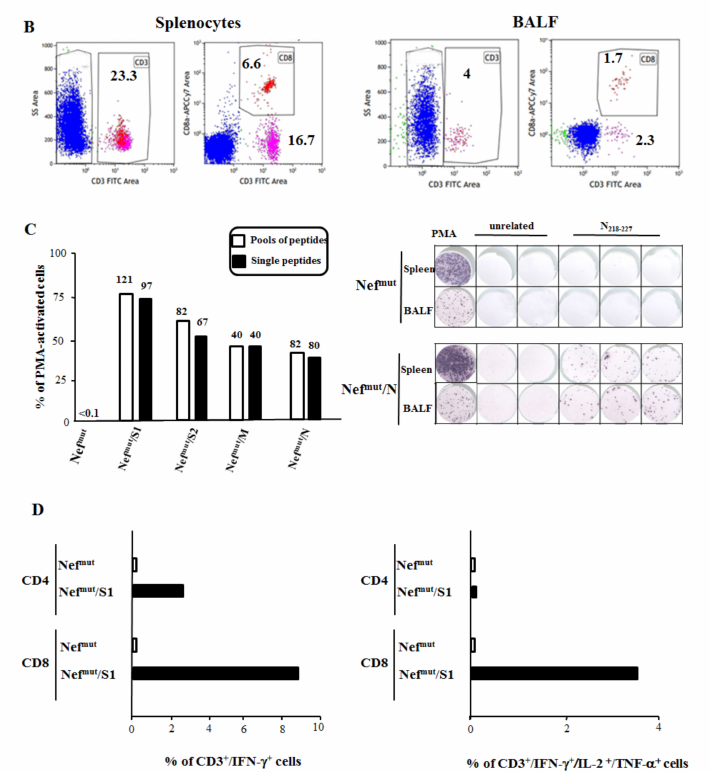
Figure 5. SARS-CoV-2 -specific total cell and CD8 + T cell immunity in both spleens and bronchoalveaolar lavage fluids (BALFs) of mice immunized i.m. by Nef mut -derived DNA vectors. ( A ) Total cell and CD8 + T cell immune responses in C57 Bl/6 and, for immunization with Nef mut /S2 expressing vector only, Balb/c mice inoculated i.m. with DNA vectors expressing Nef mut either alone (three mice), or fused with the indicated SARS-CoV-2 antigens (five mice per group). Total cell immune responses were measured using pools of 13- to 17-mers, whereas single octo-decamers were used to evaluate the CD8 + T cell immune responses. At the time of sacrifice, 2.5 × 10 5 splenocytes were incubated ON with either unrelated or SARS-CoV-2-specific peptides in triplicate IFN- γ EliSpot microwells. Shown are the numbers of SFUs/well as mean values of triplicates after subtraction of mean spot numbers measured in wells of splenocytes treated with unspecific peptides. Reported are intragroup mean values + standard deviations also. No virus-specific immune responses were detected using a pool of peptides from a heterologous viral product, i.e., HCV-NS3 (not shown). Circles sign values measured in cultures of splenocytes isolated from each injected mouse. The results are representative of two independent experiments. Statistical significance compared to values obtained with splenocytes from mice injected with Nef mut expressing vector was determined by Mann–Whitney U test. * p < 0.05. ( B ) FACS analysis of cell populations recovered through BALFs (right panels) compared to those from spleens (left panels). Total lymphocytes were identified through anti-CD3 labeling among which both CD4 + and CD8 + sub-populations were distinguished. Percentages of CD3 + , CD4 + , and CD8 + cells over the total of analyzed events are indicated. The data refer to mice injected with the Nef mut /N expressing vector, and are representative of eight independent analyses. ( C ) Percentages of spot-forming units (SFUs) detected in IFN- γ EliSpot microwells seeded with 10 5 cells isolated from pooled BALFs and cultivated in the presence of virus-specific peptides, as calculated relatively to SFUs scored in microwells seeded with an equal number of cells treated with PMA plus ionomycin. Cell activation was assayed using either peptides pools or single peptides. Cell samples seeded with unrelated peptides scored at background levels (not shown). Absolute SFU numbers are also indicated. The results are representative of two independent experiments. On the right, shown are raw data from a representative IFN- γ EliSpot plate where cells from both spleens and BALFs of mice injected with DNA vectors expressing either Nef mut or Nef mut /N were stimulated with either PMA plus ionomycin, an unrelated peptide, or the N specific peptide. ( D ) Intracellular accumulation of IFN- γ and IFN- γ , IL-2, and TNF- α in both CD8 + T and CD4 + T cells from BALFs of mice injected with vectors expressing either Nef mut or Nef mut /S1. Cells isolated from BALFs of five injected mice were pooled, and incubated ON with either the pool of S1 peptides, or a peptide pool of HCV-NS3 at final concentration of 1 µ g/mL for each peptide and in the presence of brefeldin A. Therefore, cells were analyzed by ICS. Shown are percentages of cytokine-expressing CD3 + /CD4 + and CD3 + /CD8 + T cells after subtraction of values measured in cultures treated with the pool of HCV-NS3 peptides. The results are representative of two independent